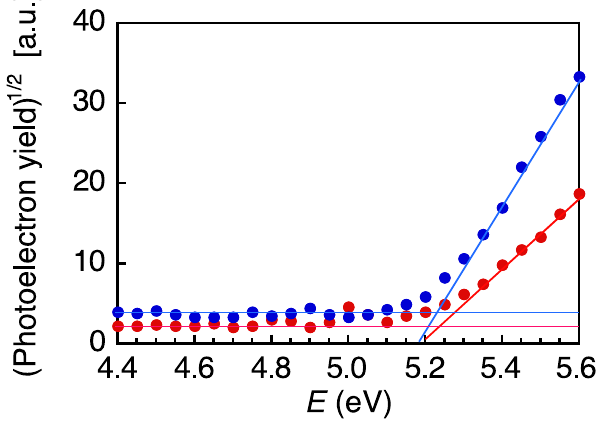
Figure 3. Photoemission yield curves of the coordination polymers 1a (red) and 1b (blue) under atmospheric